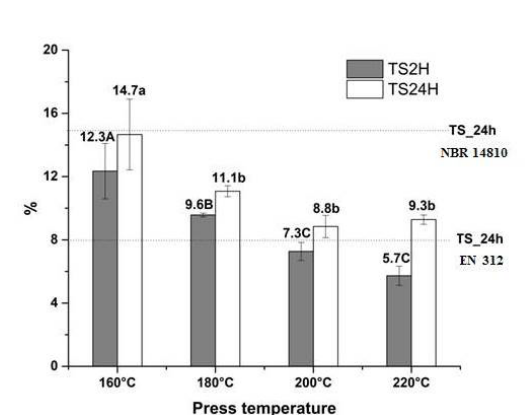
Figure 3. The swelling thickness of particleboard panels produced with sugarcane bagasse and plastic bag particles at different pressing temperatures. *Averages followed by a similar letter (uppercase for TS2h and lower case for TS24h) did not differ statistically by the Scott-Knott test at a 5% significance level.